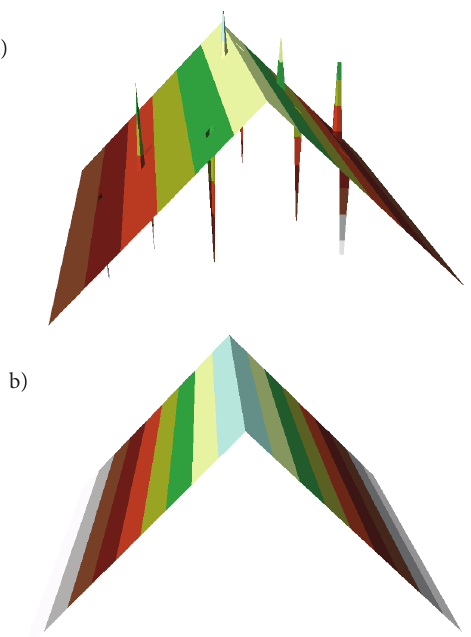
Fig. 4. Graphical representation of the points cloud of the inclined plane: a – with gross errors; b – after analysis and